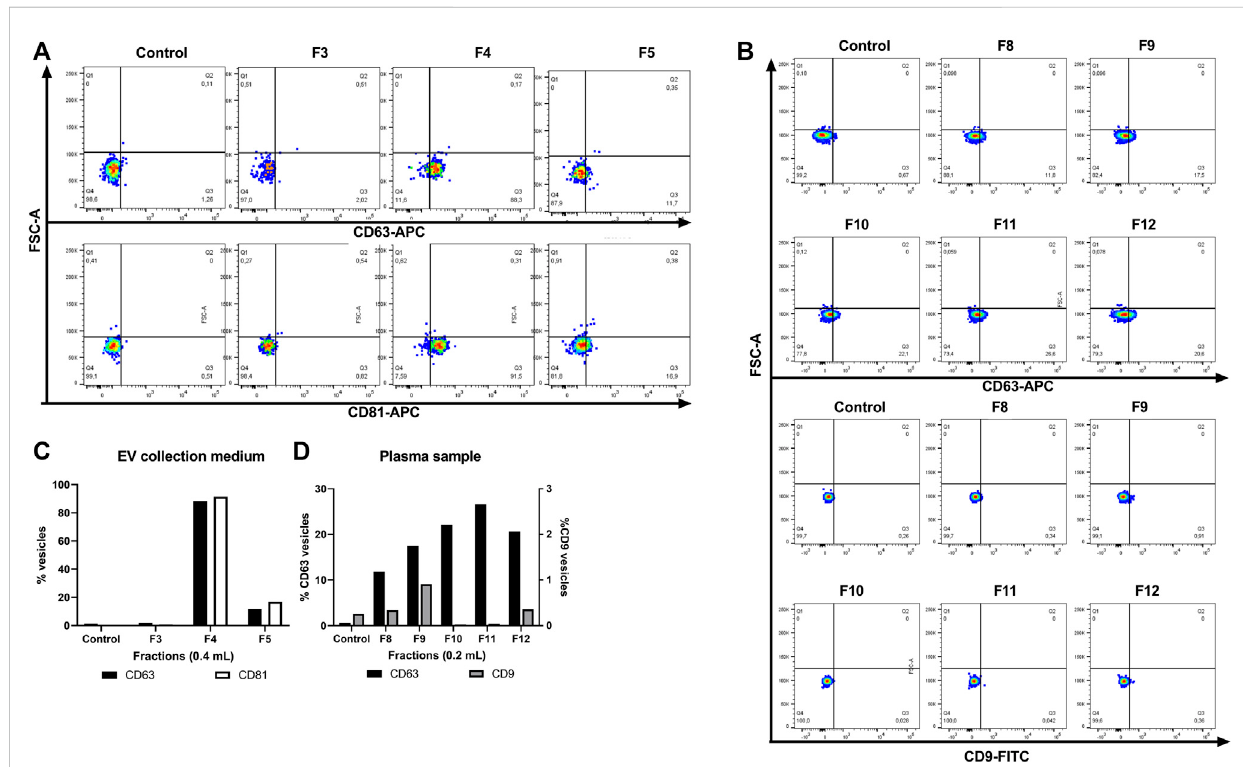
FIGURE 6 FlowcytometryanalysisofEVsisolatedfromcellculturemediaandplasmafractions.SmallEVswereisolatedfrom (A) cellmediaand (B) plasmafrom the G200/40 column. (C) Frequency of HEK293-derived small EVs CD63 + and CD81 + , (D) plasma-derived small EVs CD63 + and CD9 + . Small CD63 positive EVs were captured from each fraction employing Dynabeads ® coated with anti-CD63 and stained with anti CD63-APC (Upper panel) or anti CD81-APC or anti CD9-FITC (Lower panel). Q3 represents small EV-beads-CD63 positive staining.